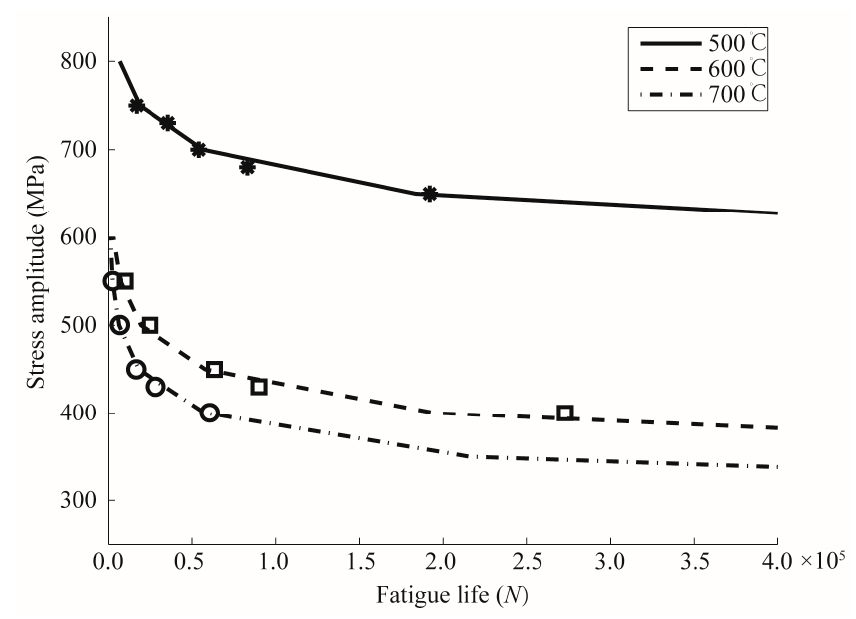
Figure 4. S–N curves at tempering temperatures of 500 °C, 600 °C, and 700 °C.